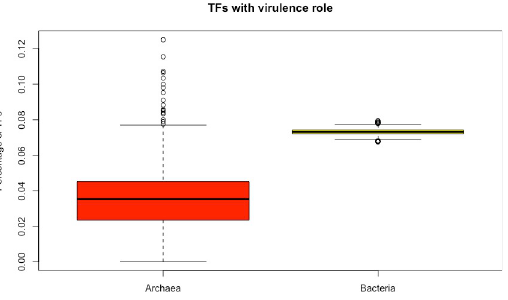
Fig 6. Proportion of TFs with virulence roles in archaea and the normalized values in representative bacterial dataset. The distributions of virulence fraction are different from each other (Wilcoxon test, p-value < 2.2e-16).